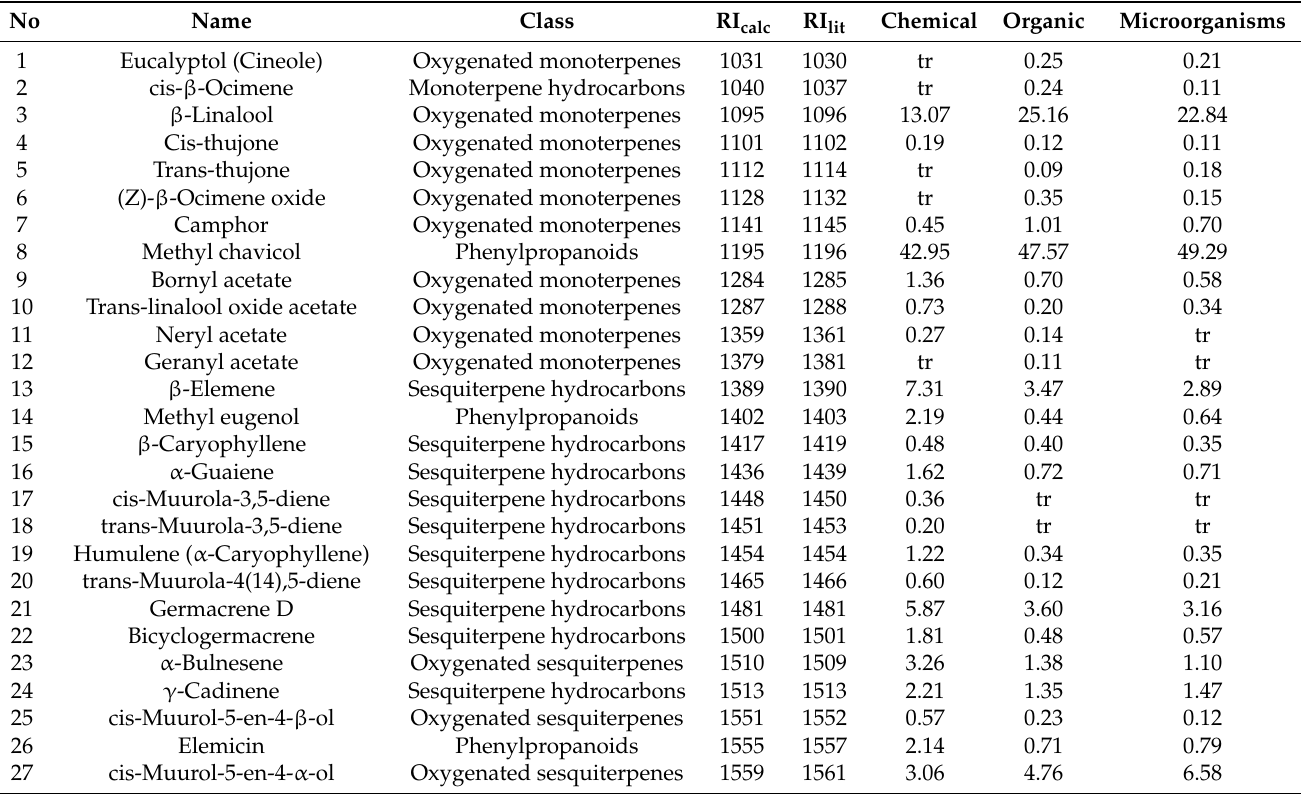
Table 9. Influence of fertilization on essential oil composition of ‘Aromat de Buzau’